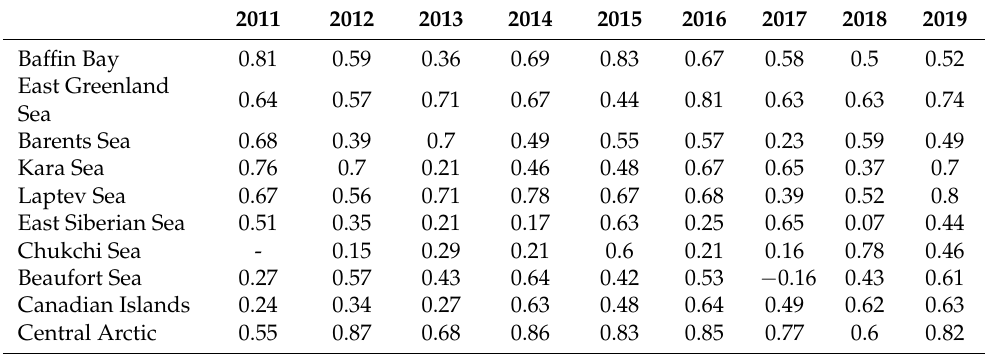
Table 7. Spearman’s rank correlation coefficients ( p < 0.001) between MISR-derived SIR and AWI CS-2 SMOS thickness by region. Correlations above this confidence interval are not